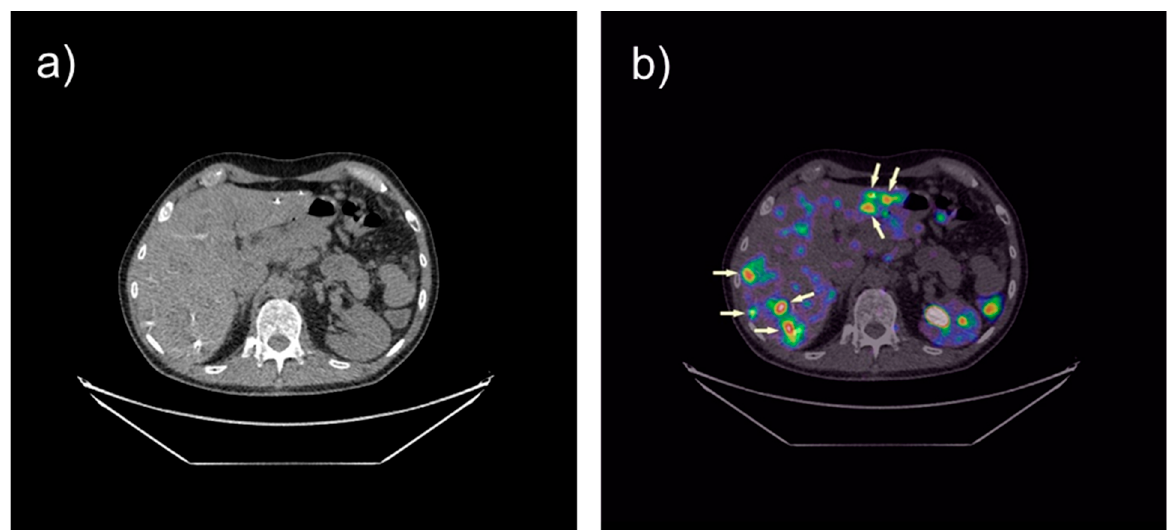
Figure 3. CT ( a ) and fused [ 68 Ga]Ga-DOTA-MGS5 PET/CT ( b ) images in transverse orientation. Multiple liver metastasis (arrows) in a male patient with advanced MTC are visible; images performed 4 h after injection of 165 MBq (<50 µg peptide); courtesy of Prof. Alicja Hubalewska-Dydejczyk.